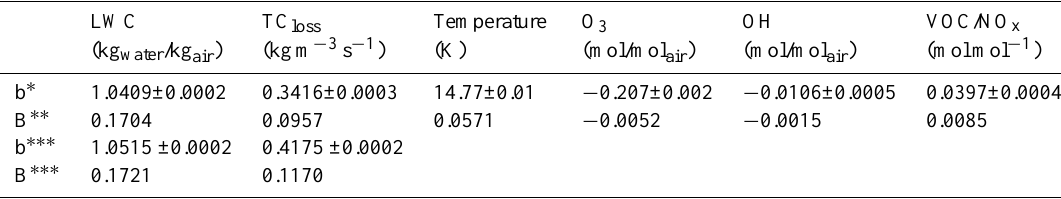
Table 2. Regression coefficients (b) and their standardized values (B) from multiple linear regression model (with log-transformation) between P SOAcld (unit: kgm − 3 s − 1 ) and all six factors (or only LWC and TC loss are considered). LWC TC loss Temperature O 3